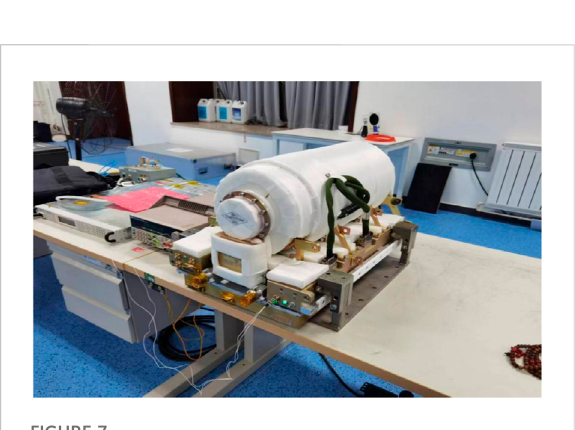
FIGURE 7 SAHM covered by thermal insulation material.